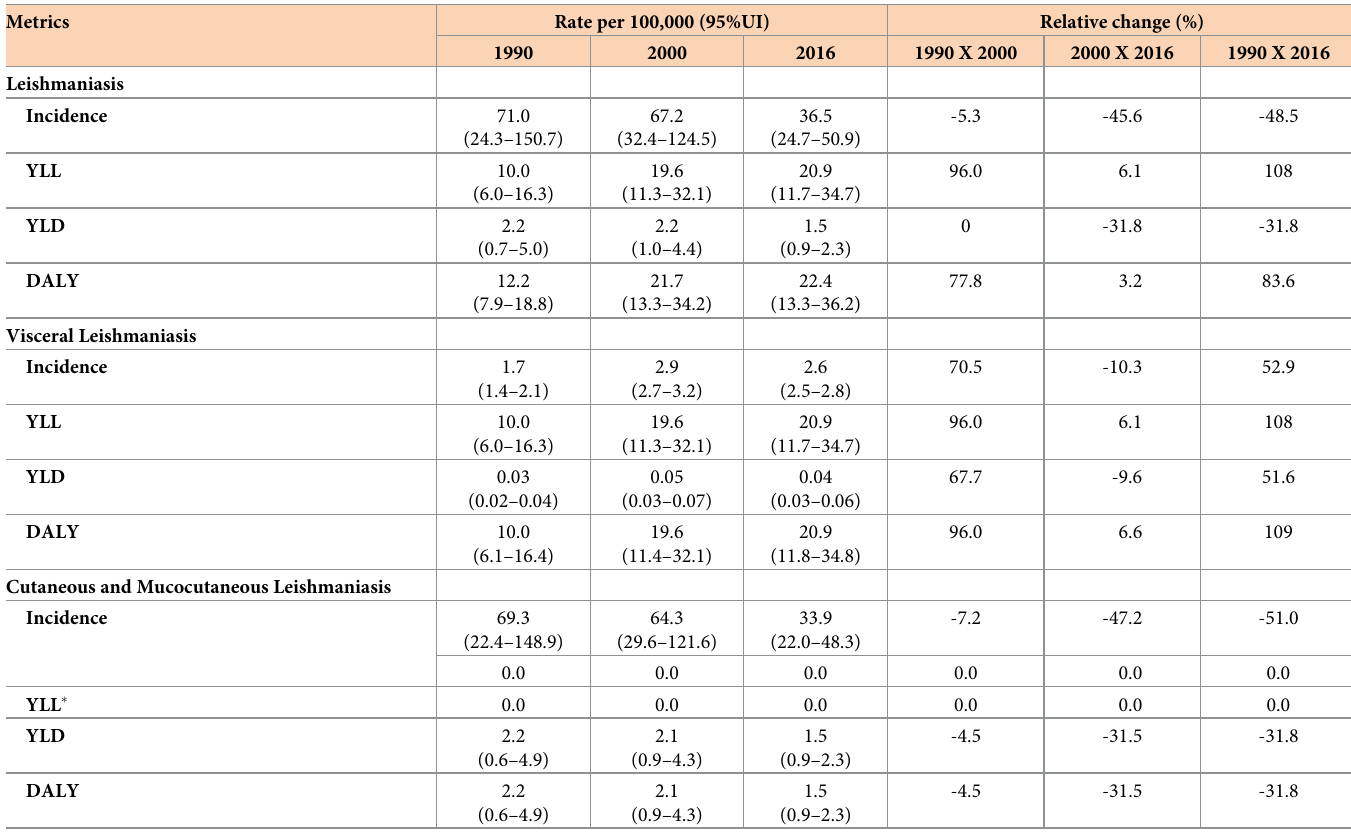
Table 1. Age-standardized rates of incidence and mortality for leishmaniasis per 100,000 inhabitants and relative change regarding years of life lost (YLL), years lived with disability (YLD), and disability-adjusted life years (DALY), Brazil,1990–2016, GBD Study 2016.